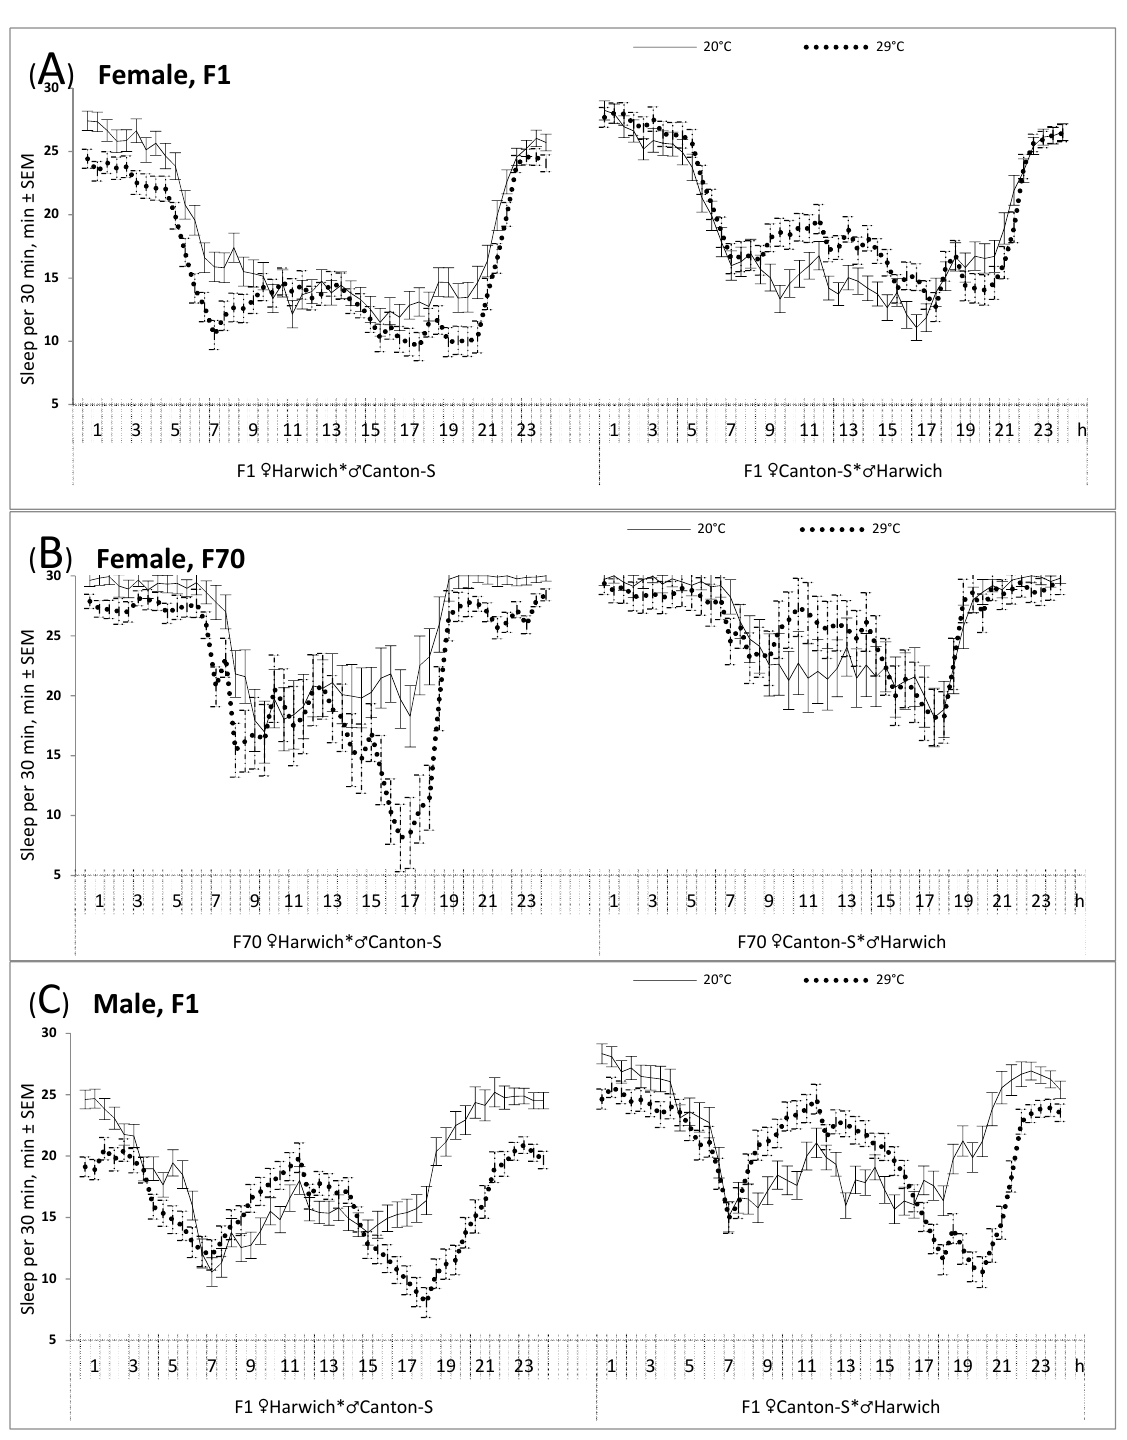
Figure 2. The 24-h sleep patterns in male and female intra-specific hybrids of two cross directions. Sleep, defined [24] as 5 consecutive minutes of absence of any locomotor activity, in min. It was averaged on 30-min intervals; 20 °C and 29 °C: The 24-h pattern in constant darkness under two air temperatures (obtained by averaging over 2nd–5th days and then by averaging over individual flies); ( A , B ) Females from F1 and F70, the 1st and 70th generation of hybrids, respectively; ( C ) Males from F1. ♀ H ♂ C-S: Crosses from females of Harwich strain and males of Canton-S strain; ♀ C-S ♂ H: The reciprocal crosses (Canton-S females and Harwich males, females are sterile under high developmental temperature); SEM: Standard Error of Mean; h: Clock Hour. See some results of rANOVAs and sample sizes for each graph in Table 2.